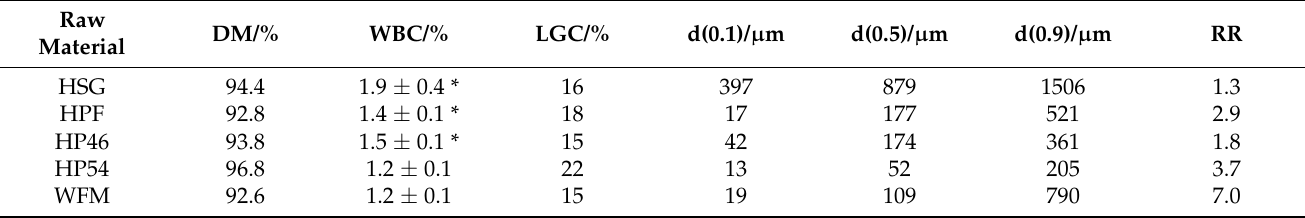
Table 1. Means with standard deviations (where applicable) of dry matter (DM), water-binding capacity (WBC) and least gelation concentration (LGC) of hemp seed grit (HSG), hemp press cake flour (HPF), hemp press cake flour protein (46%) (HP46), hemp press cake flour protein (54%) (HP54) and half-and-half mixture of wheat and whole wheat flour (WFM). Median particle size and relative particle size range (RR), as well as first and last deciles, are also reported for all raw materials. WBC and LGC were determined in